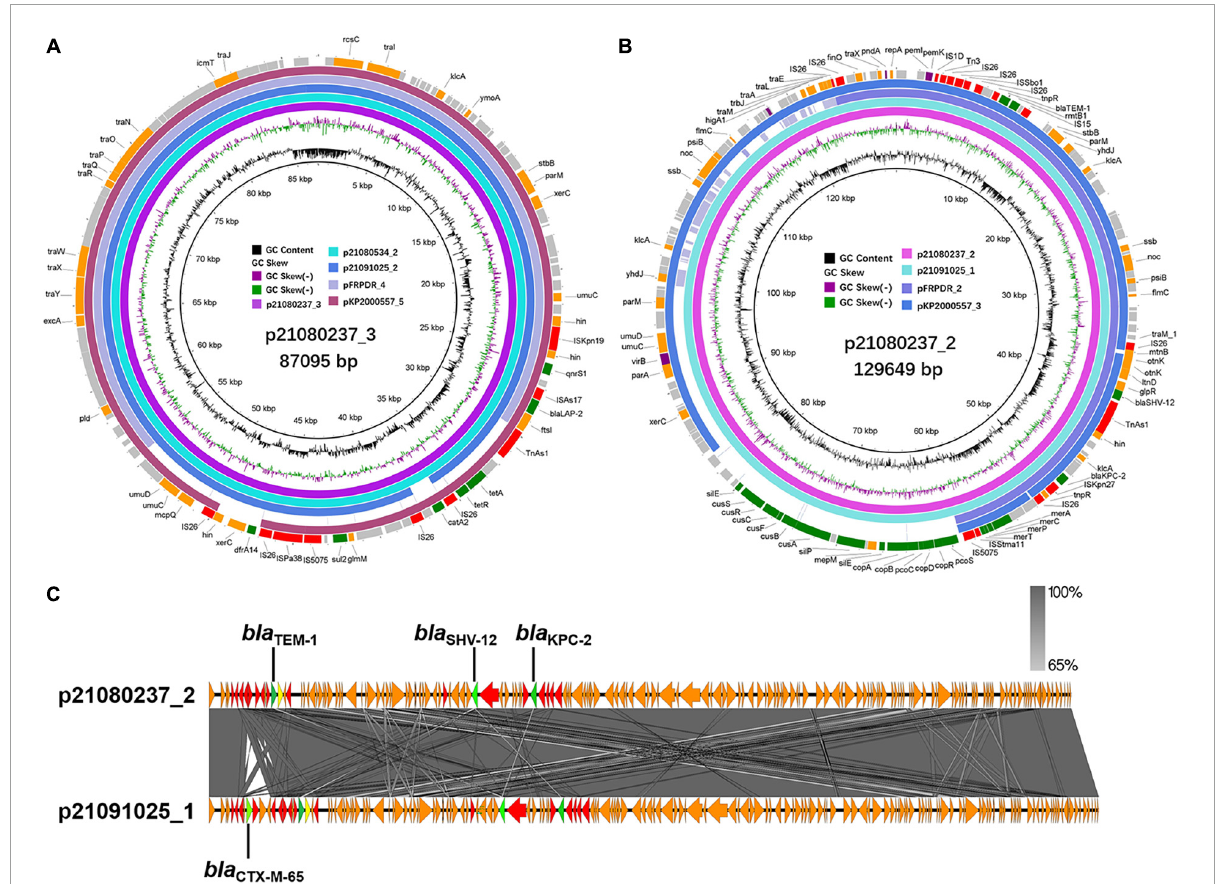
FIGURE4 Alignment of MDR plasmids in ST11 MDR-hvKps. (A) Alignment of plasmid p21080237_3, plasmid p21080534_2, plasmid p21091025_2, plasmid pFRPDR_4, and plasmid pKP2000557_5 using the BLAST Ring Image Generator (BRIG 0.95) (Alikhan et al., 2011). (B) Alignment of plasmid p21080237_2, plasmid p21091025_1, plasmid pFRPDR_2 and plasmid pKP2000557_3. (C) Alignment of plasmid p21080237_2 and p21091025_1 using Easyfig 2.2.5 (Sullivan et al., 2011). ORFs encoding transposases are colored in red, and drug resistance genes are colored in